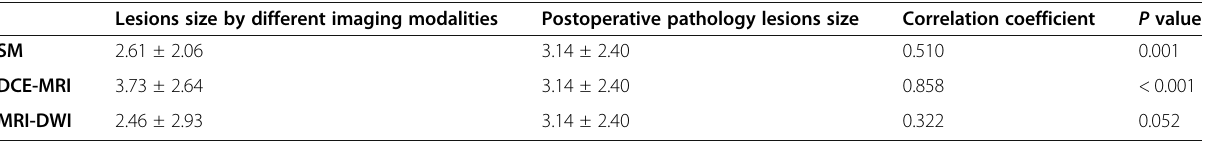
Table 1 Correlations between lesion size measured by different imaging modalities and postoperative pathology results in upfront surgery group Lesions size by different imaging modalities